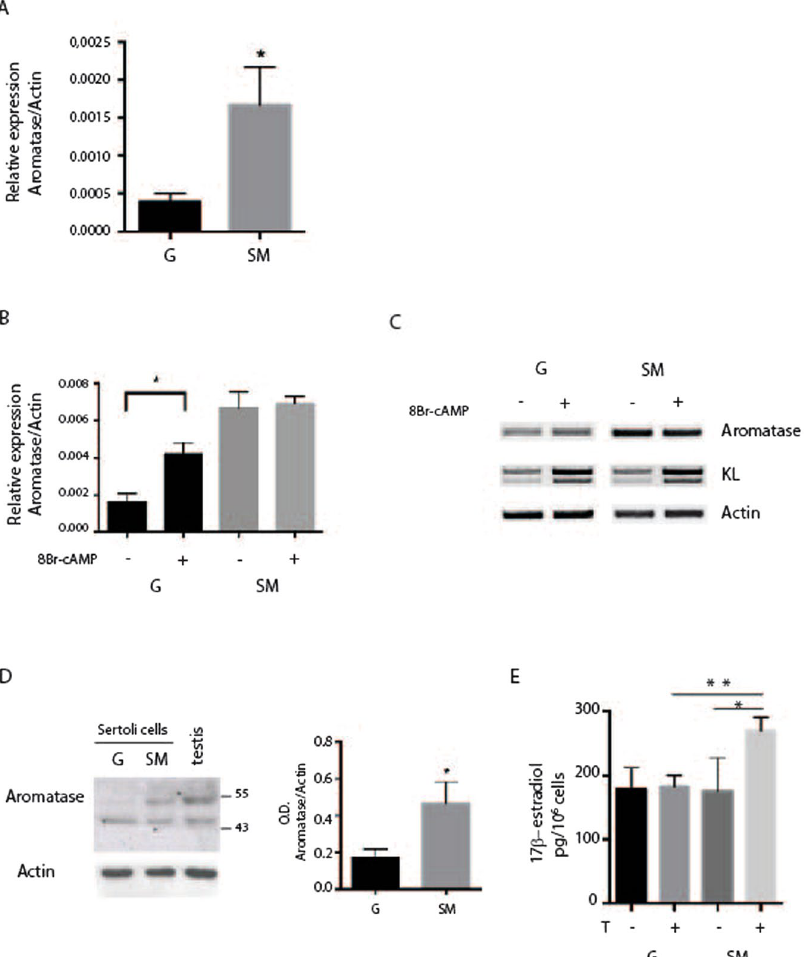
Figure 4. SM increases P450-aromatase expression in Sertoli cells. Sertoli cells were cultured for 48 h at G or in RCCS. ( A ) Real time PCR of P450-aromatase showing a strong increase of mRNA level under microgravity condition. ( B ) Real time-PCR for P450-aromatase in Sertoli cells treated or not with 1 mM 8-Br-cAMP. cAMP inducibility is lost under SM. ( C ) Semiquantitative RT-PCR of P450-aromatase and KL in Sertoli cells treated or not for 48 h with 1 mM 8-Br-cAMP. P450-aromatase expression is stimulated by 8-Br-cAMP at G but not under SM, while KL expression is stimulated by 8-Br-cAMP in both culture conditions. ( D ) Western blot analysis of P450-aromatase in Sertoli cells after 48 h of culture at G or under SM. Histogram on the right reports the mean of densitometric analysis of four different experiments. Values were normalized by reference to values for actin. ( E ) Chemiluminescence immunoassay for estrogen level in the culture medium of Sertoli cells. Sertoli cells were cultured in the presence or absence of 50 nM testosterone at G or in SM for 48 h. SM causes an increase of estrogen in the medium when cells are treated with testosterone. At least three different experiments were performed. Bars represent s.d. Asterisks indicate: * P < 0.05 and ** P <